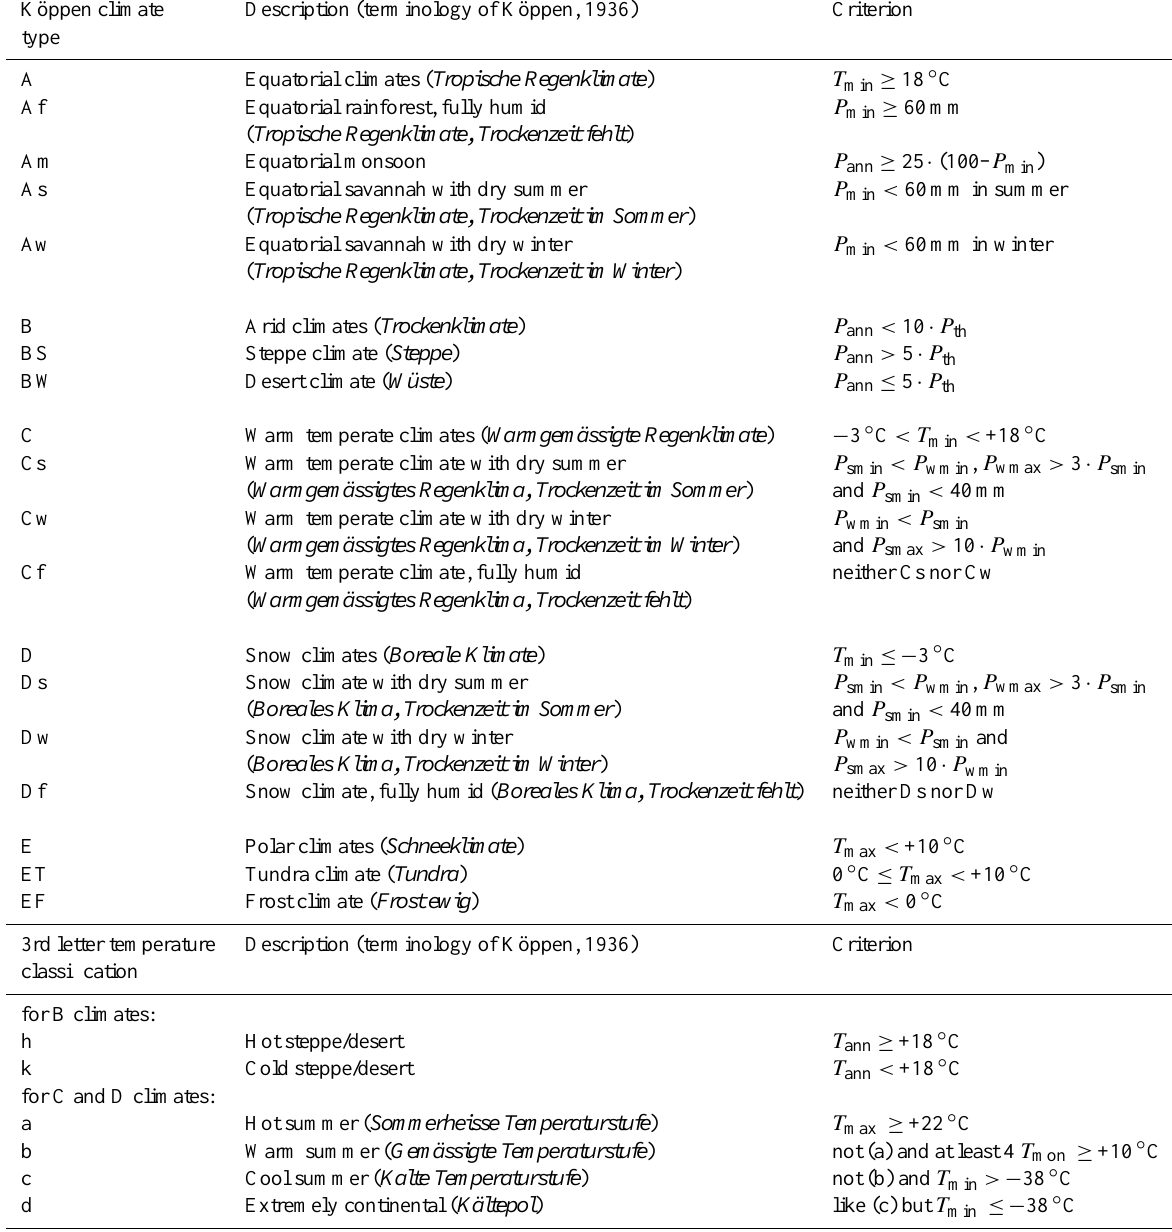
Table 2. Key to Köppen climate types (after Kottek et al.,